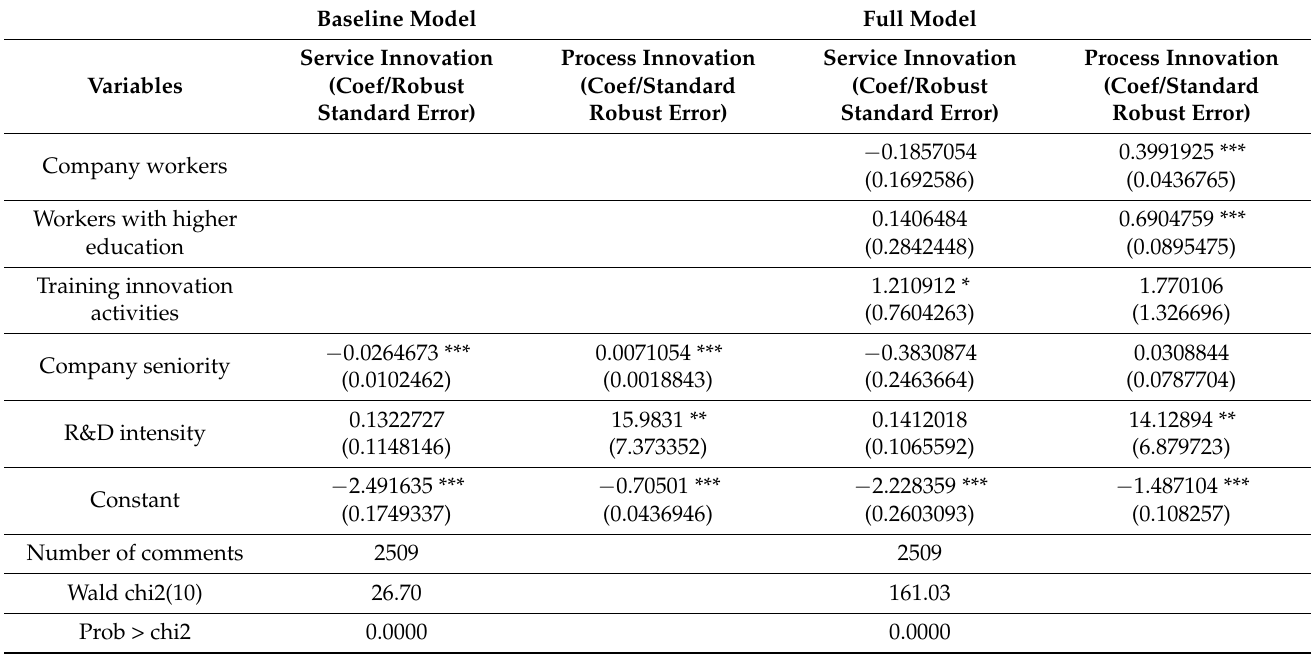
Table 7. Bivariate probit regression